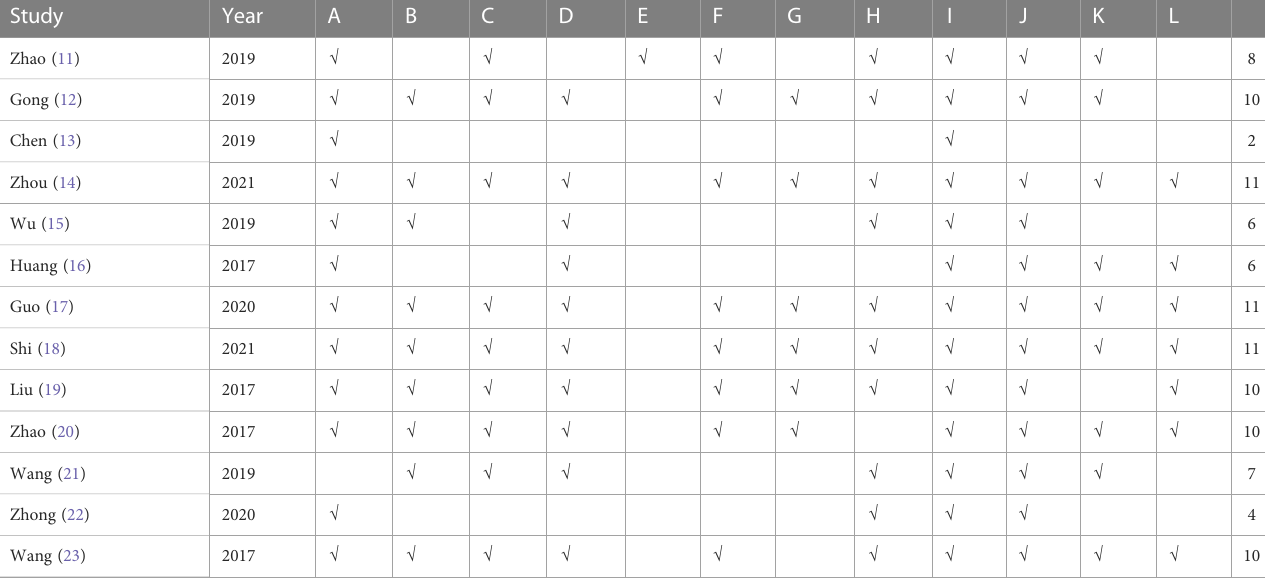
TABLE 3 ERAS elements included in the